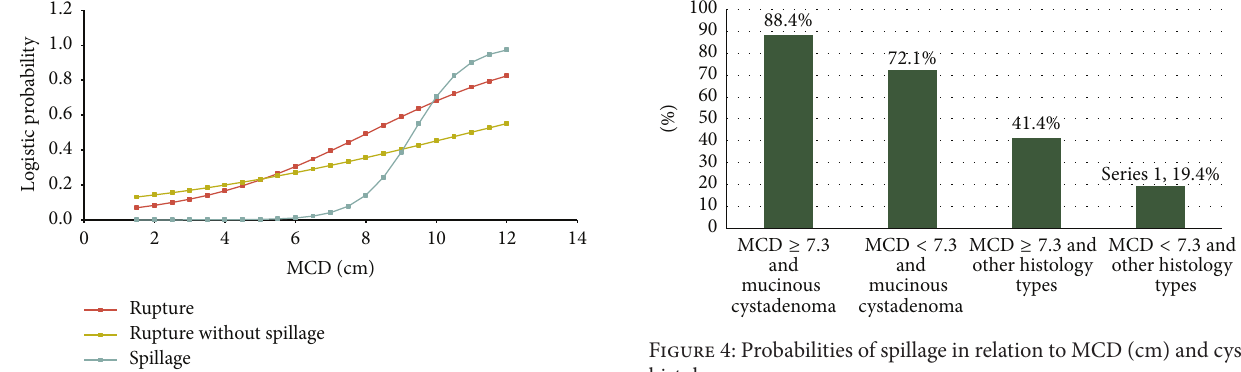
Figure 2: Probabilities of rupture with and without spillage in relation to MCD (cm).